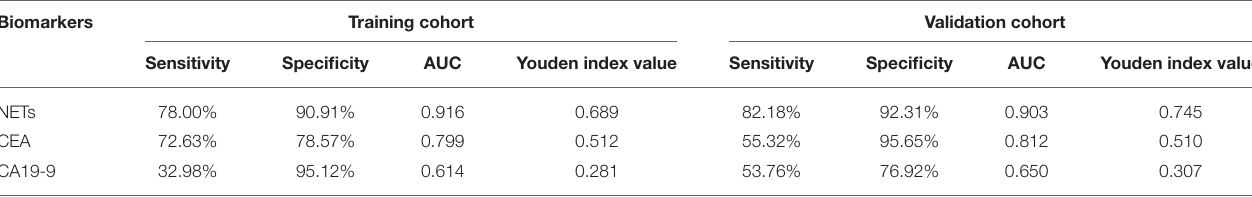
TABLE 4 | Diagnostic performance of NETs in the serum of GC patients.